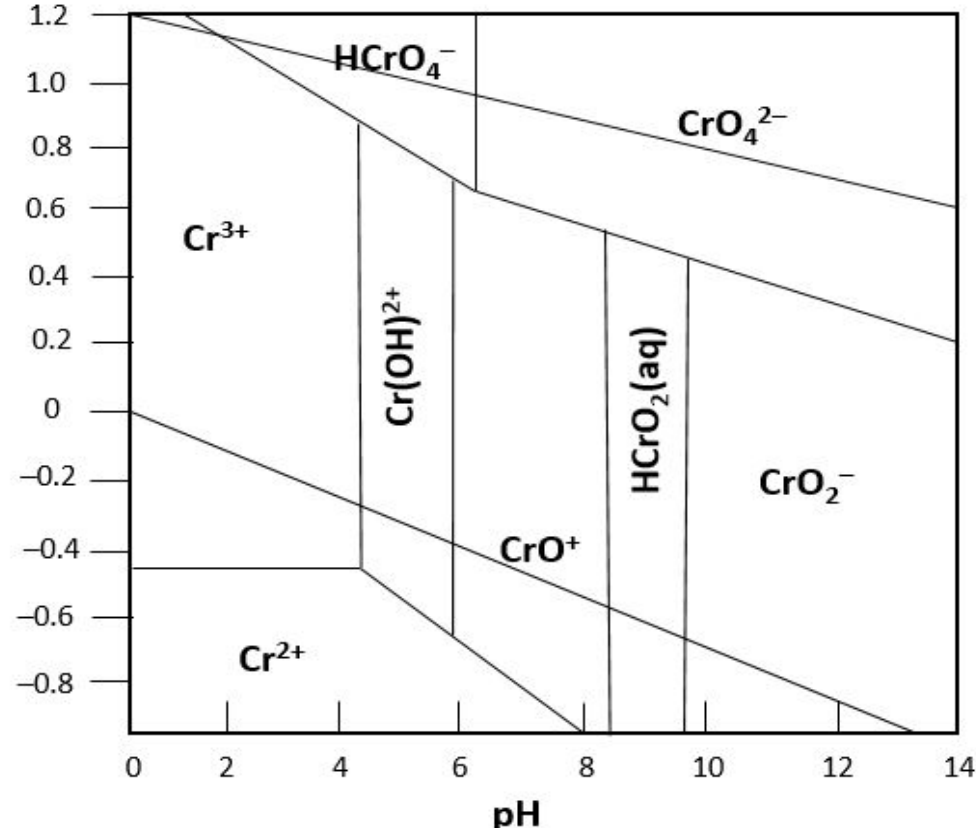
mend that Cr 6+ mixtures, especially those that are water-insoluble, are responsible for dif- ferent types of DNA harm and carcinogenicity [29,30]. Consequently, urgent and efficient Cr clean-up technology is essential. Figure 2. Pourbaix diagram for Cr chemical species in aqueous solution (Chen et al. 2021) [13].